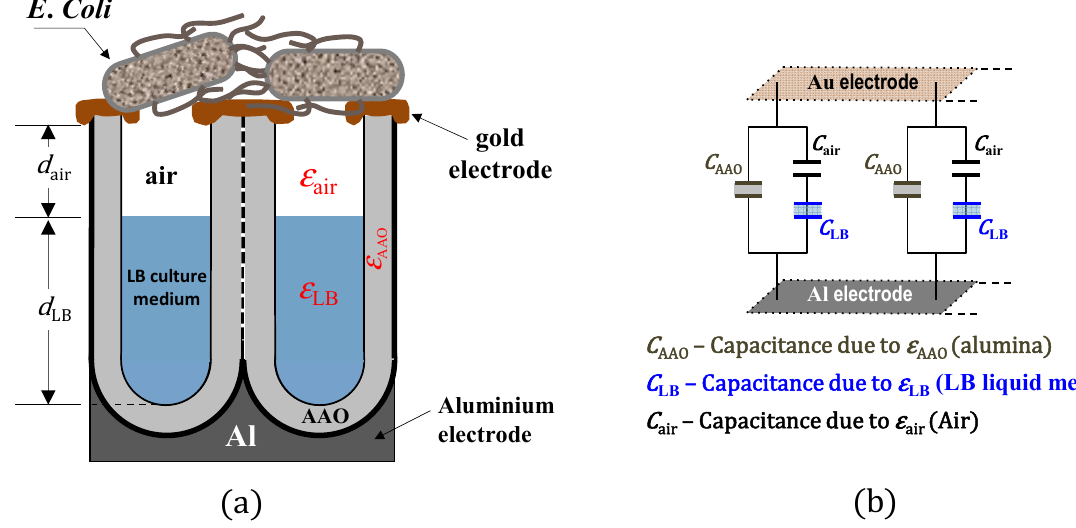
Figure 14. Schematic representation of the NP-AAO capacitive-type touch sensor: ( a ) cross-sectional (side) view of the nanoporous alumina structure where the volume inside each pore is partially filled by the LB culture medium and air, and ( b ) equivalent circuit of the NP-AAO capacitive-type touch sensor device.